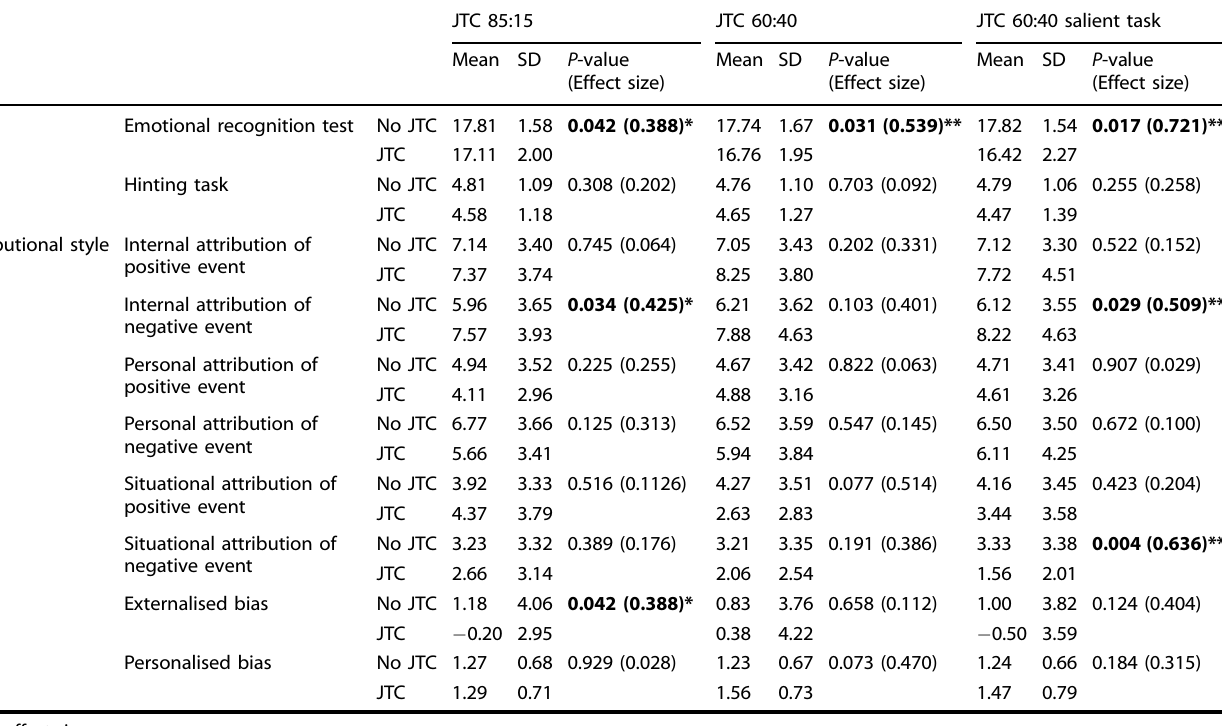
Table 3. Comparison of people who jumped to conclusions or not, regarding attributional style, emotional recognition, and ToM, using Student ’ s t-tests.